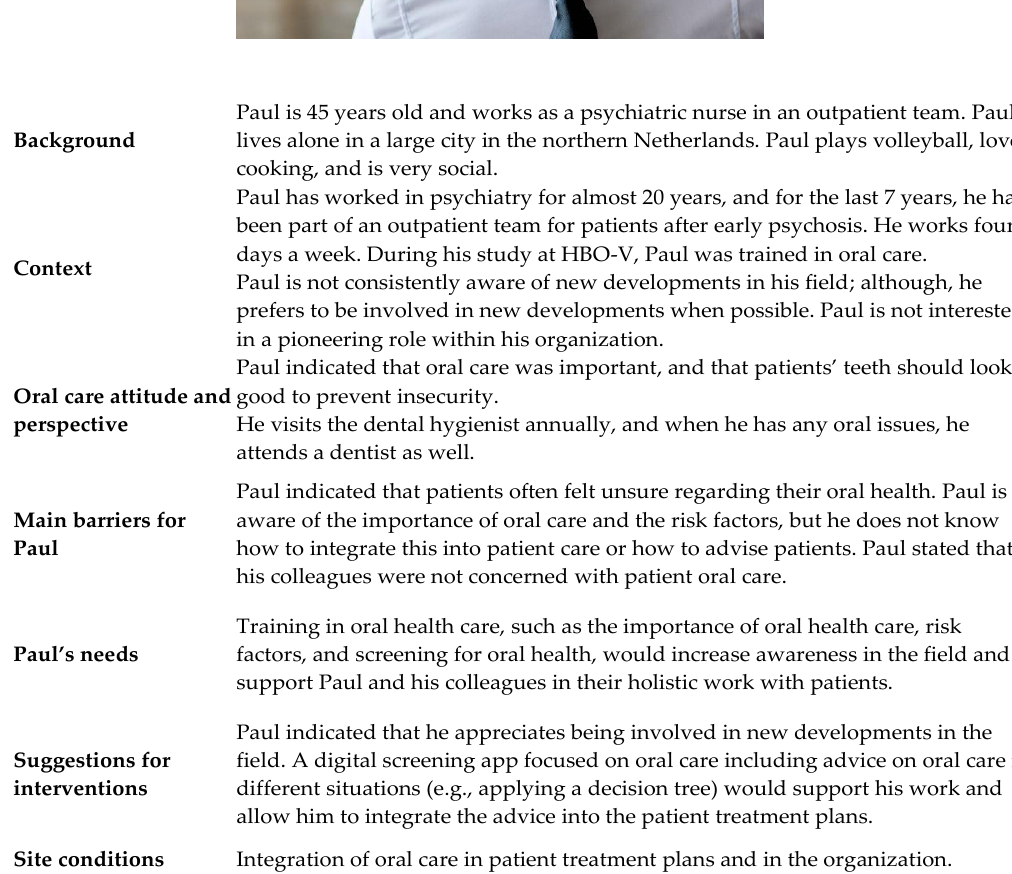
Figure 5. Persona Paul.